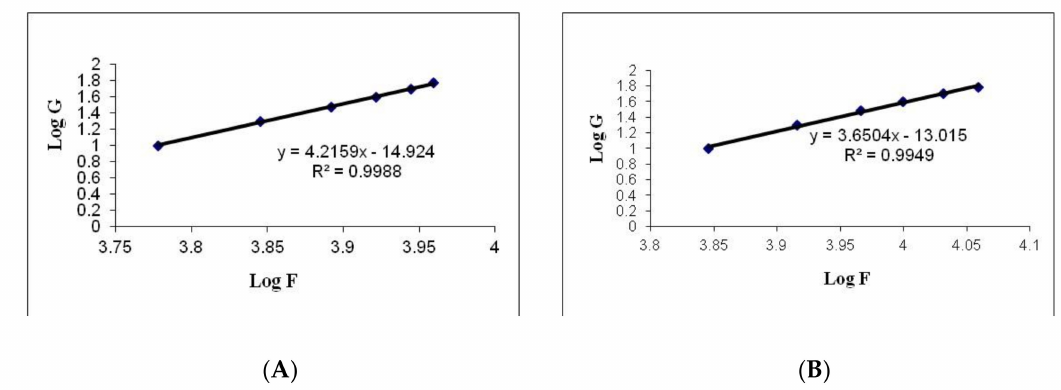
Figure 7. Representative plots of the logarithm of the rate of shear (G) versus the logarithm of the shearing stress (F) for ( A ) blank hyaluronic acid hydrogel and ( B ) HA-FS-NTF. Table 8. Rheological parameters of blank hyaluronic acid hydrogel and HA-FS-NTF.